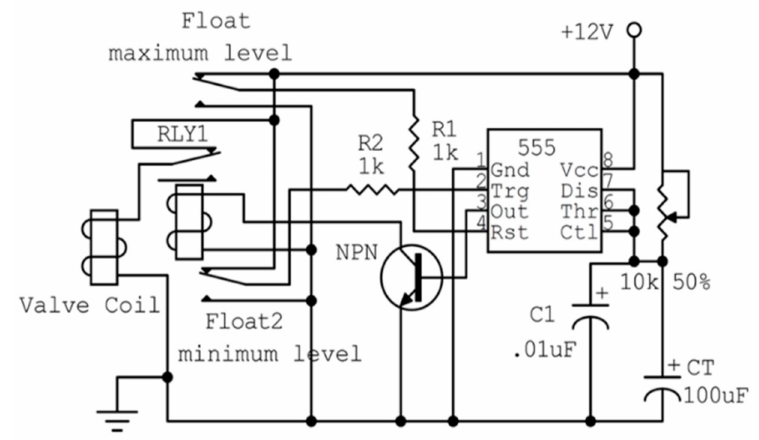
Figure 2. Circuit diagram of water level control in the humidifier reservoir.